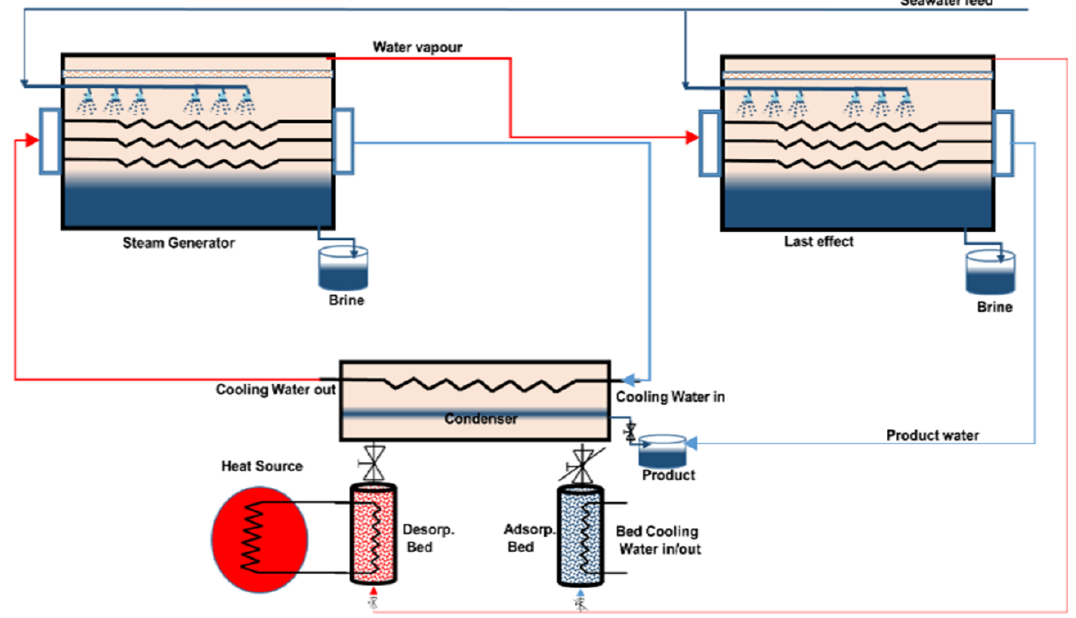
Figure 13. Hybrid MED–ADD (MEAD).